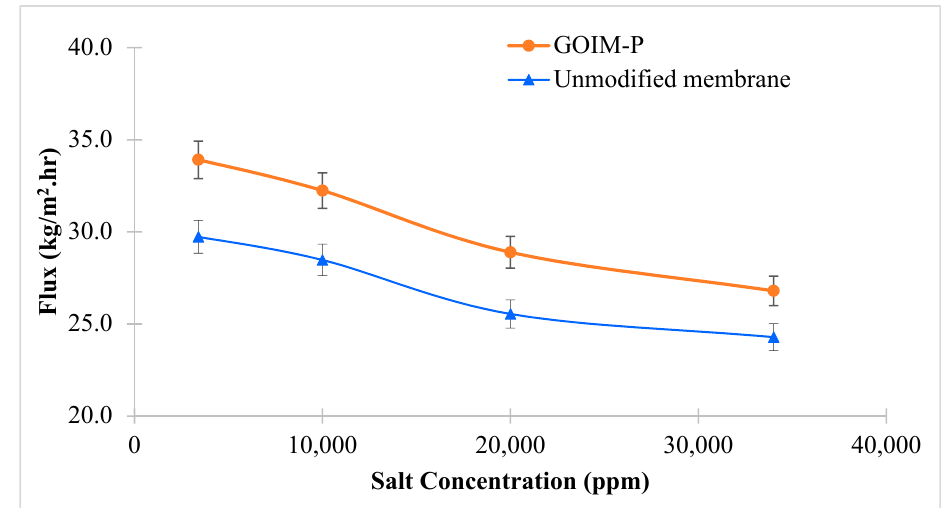
Figure 7. Effect of varying feed concentration on water vapor flux at feed flow rate of 150 mL/min and operating temperature of 60 °C.